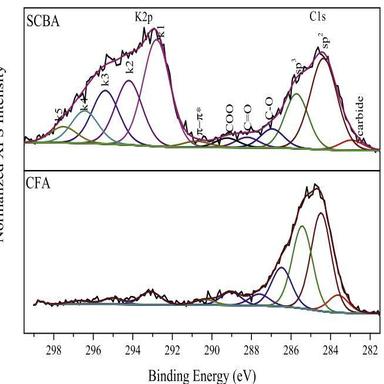
High-resolution O1s XPS spectra of the SCBA and CFA.